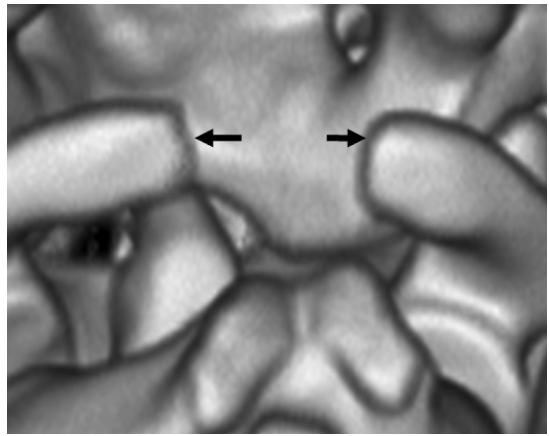
Figure 7 - A coronal 3DCT scan in a 3-year-old boy showed massive malsegmentation throughout the entire cervical